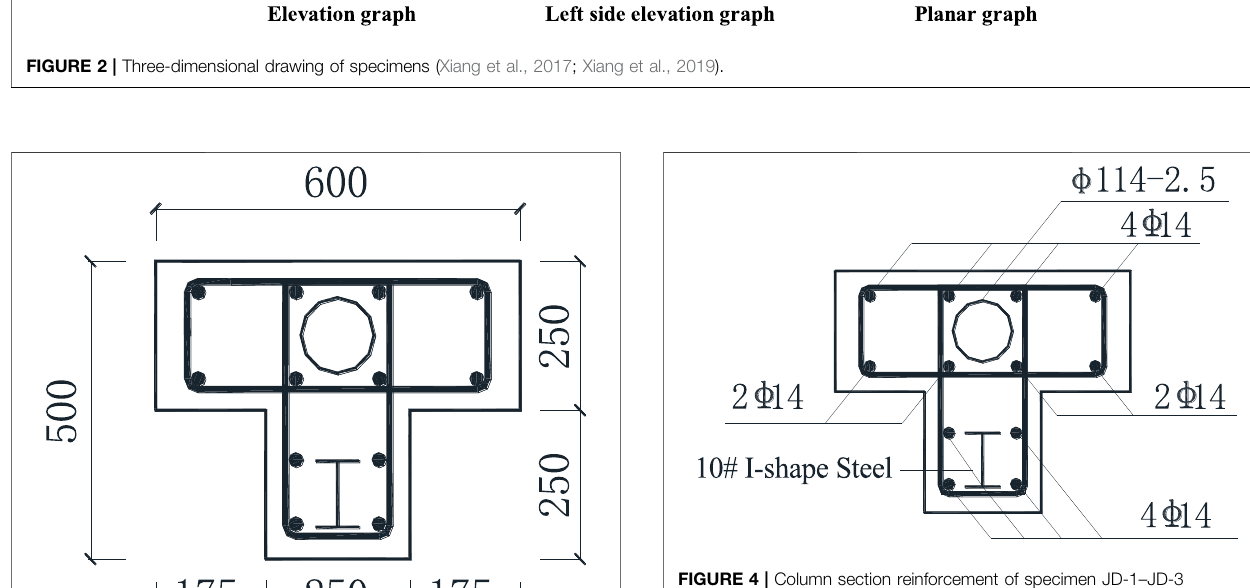
FIGURE 4 | Column section reinforcement of specimen JD-1 – JD-3 (Xiang et al., 2017; Xiang et al.,